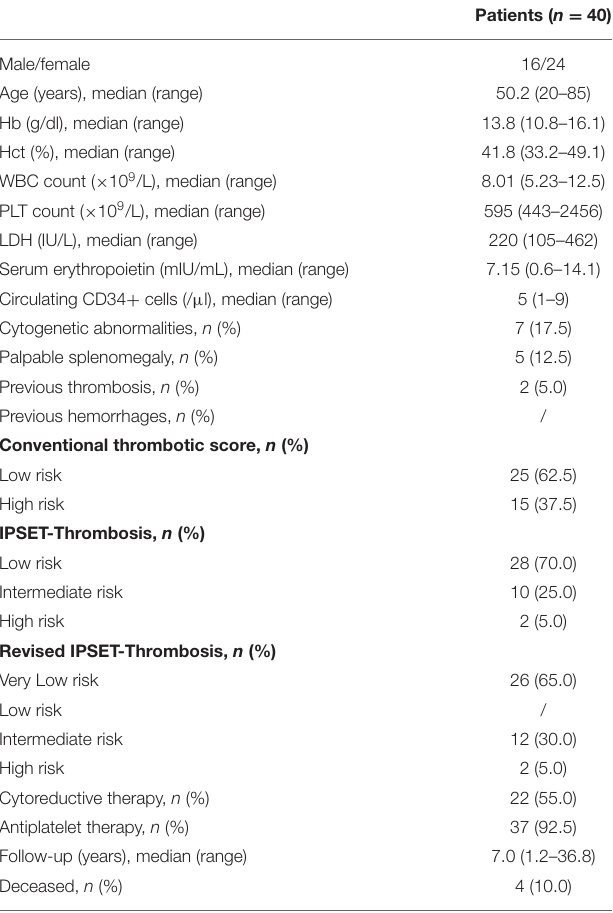
TABLE 1 | Baseline clinical and laboratory features of 40 triple-negative ET patients.